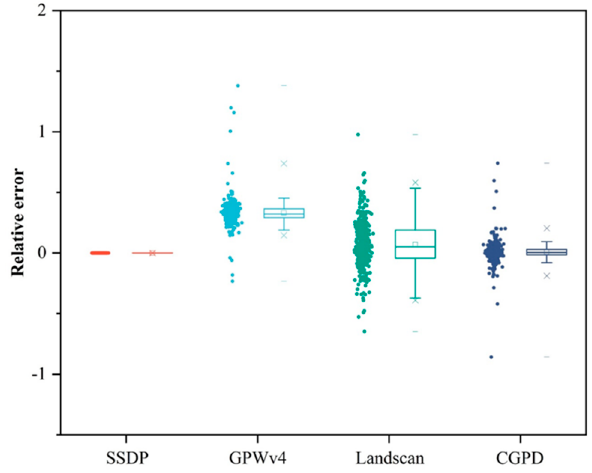
Figure 5. The scatter plot of relative error in 435 counties of four population grids.